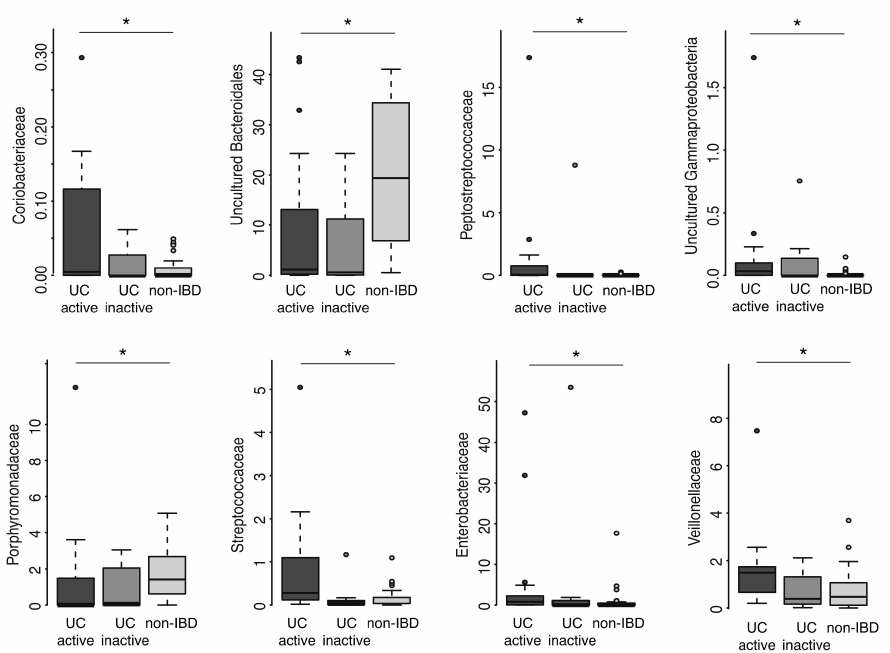
Figure 2. Family-level microbiota di ff erences between active, inactive ulcerative colitis and non-IBD controls. Microbiota abundance expressed as relative abundance. An asterisk indicates statistical significance between active UC and non-IBD